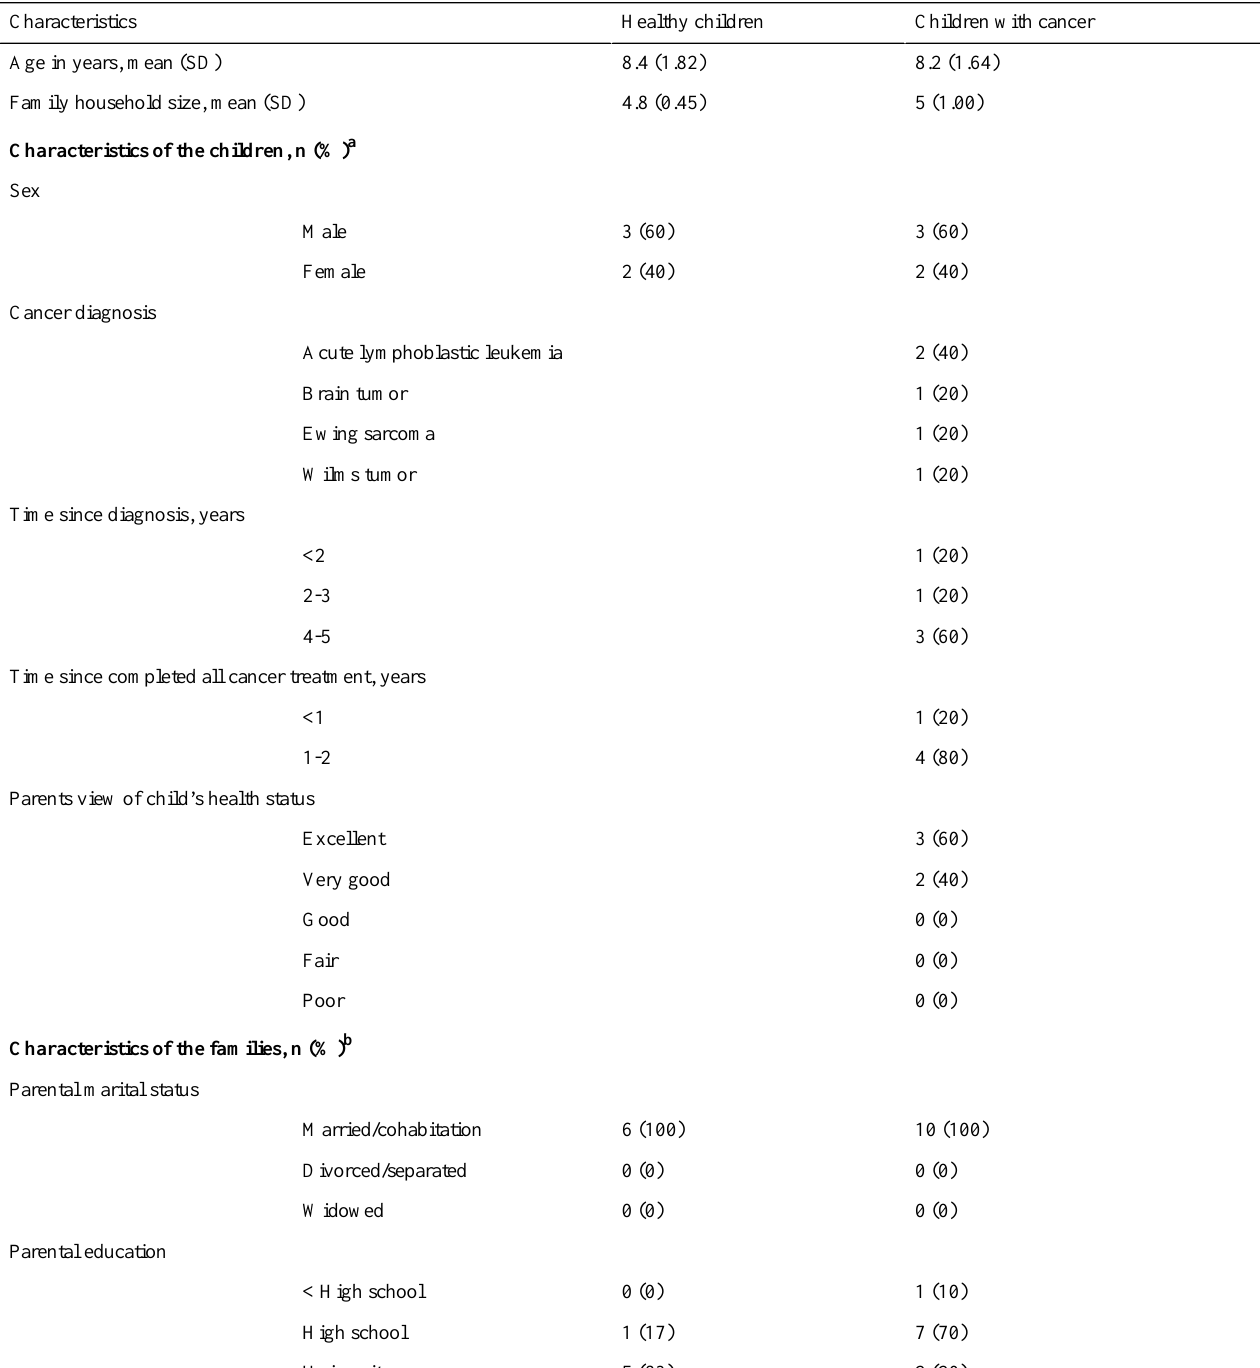
Table 1. Child and family characteristics.